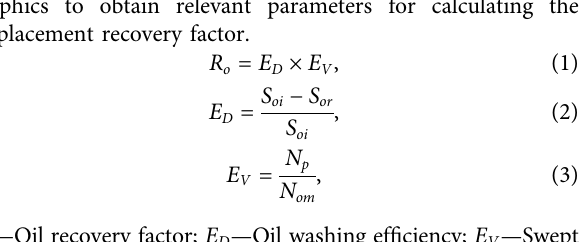
Frontiers in Energy Research |